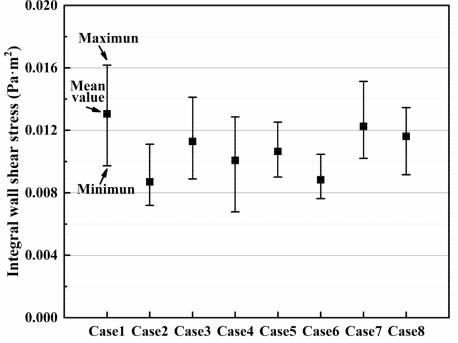
Figure 11. Comparison of the integral wall shear stress in the eight